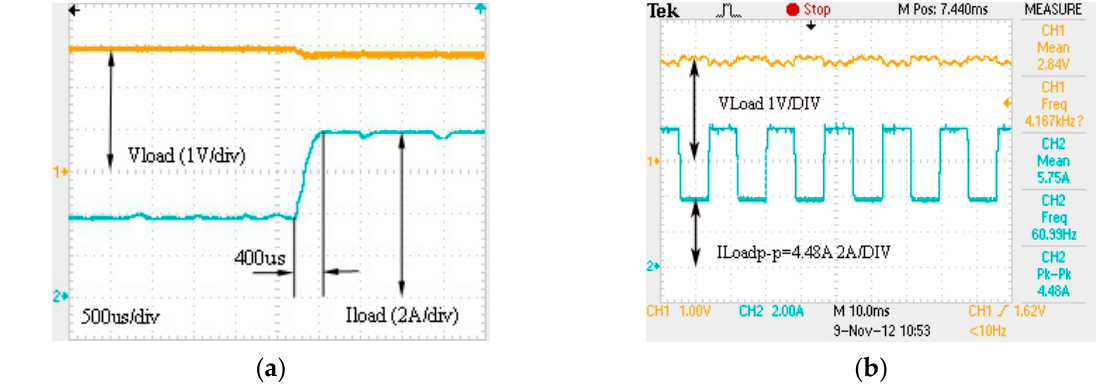
Figure 9. Test results with PID controller ( a ) step response from 4 A to 8 A, ( b ) 60 Hz pulse current sink mode (10 ms/div).